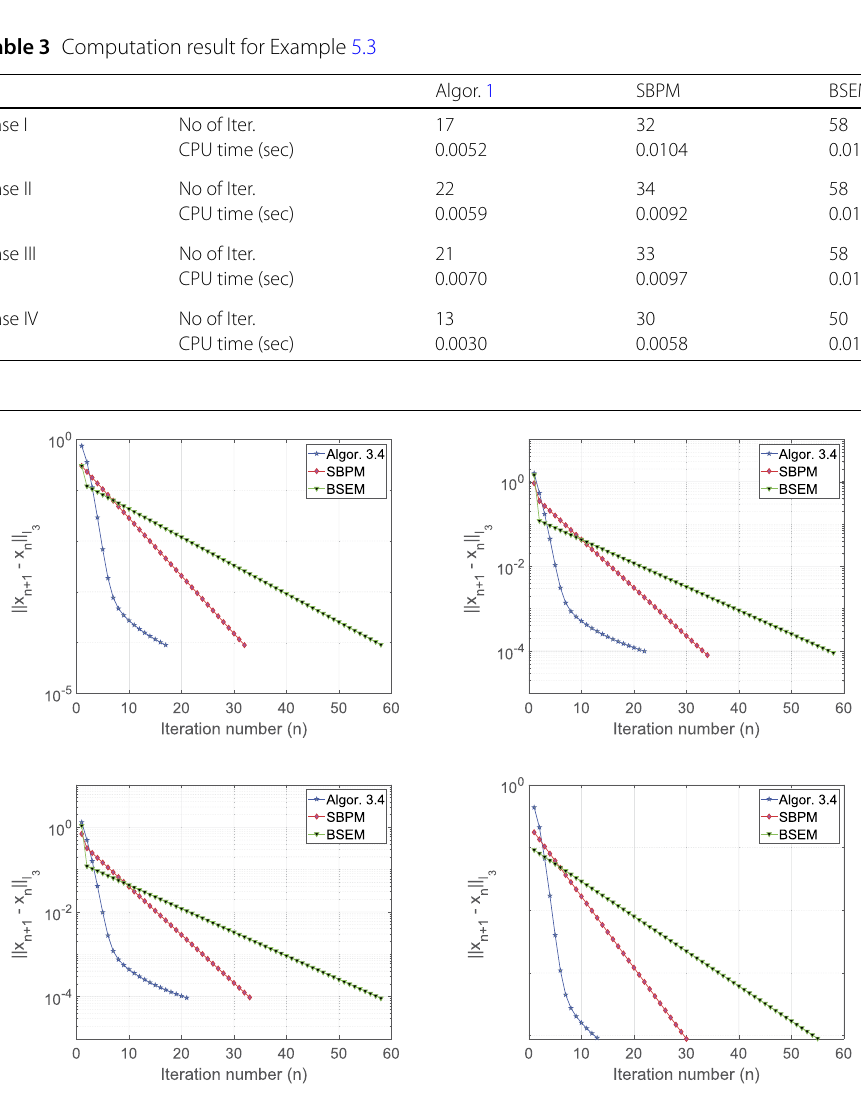
Figure 3 Example 5.3, top left: Case I; top right: Case II;bottom left: Case III; bottom right: Case